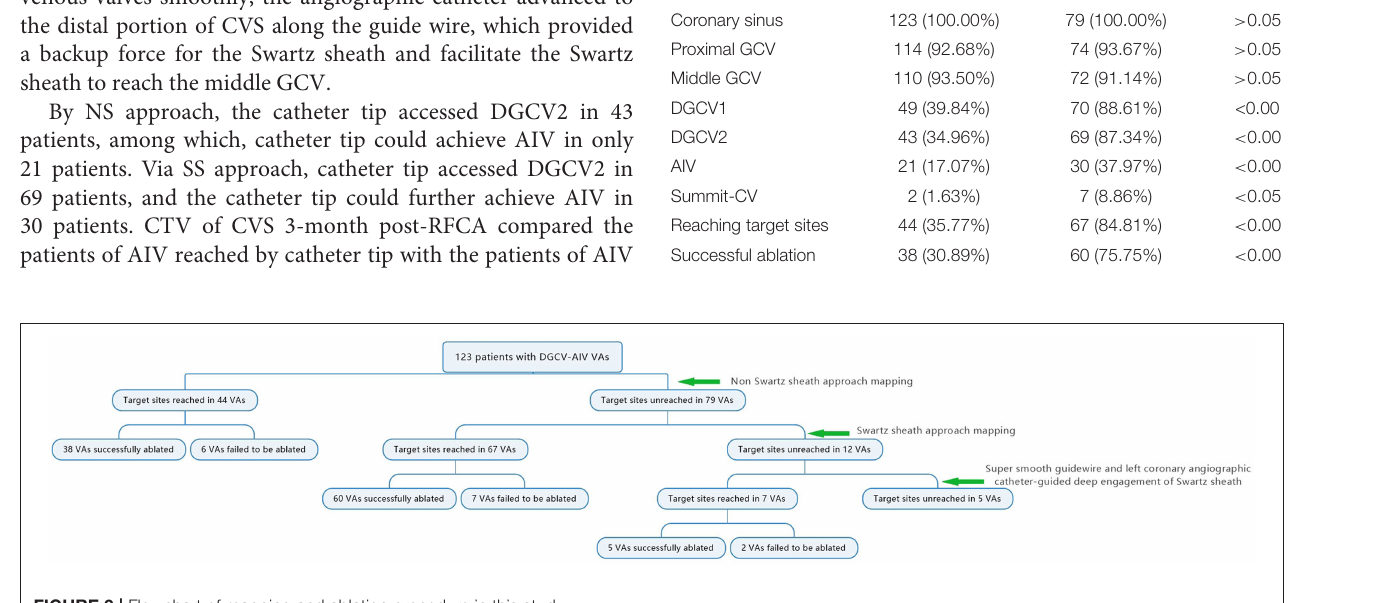
FIGURE 3 | Flowchart of mapping and ablation procedure in this